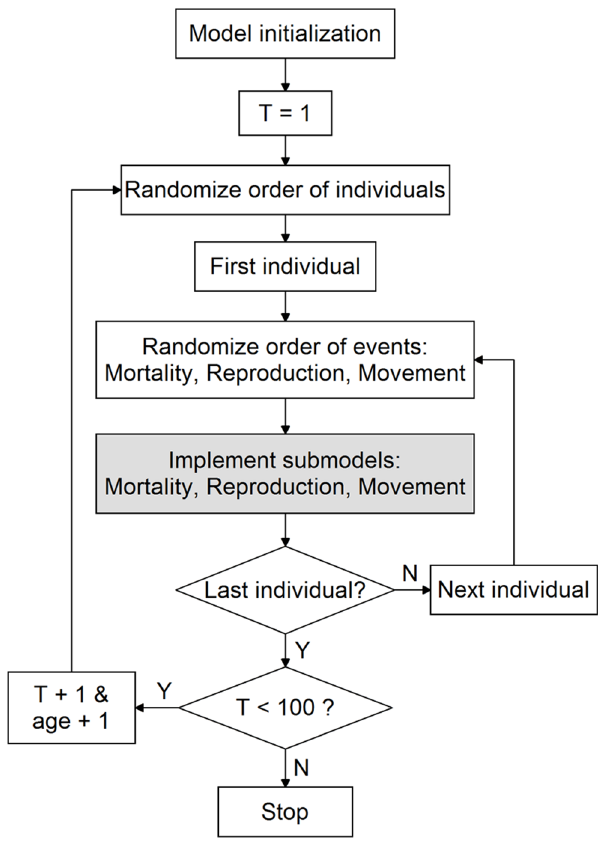
Figure 1. Flow diagram of the main routine used in the simulation